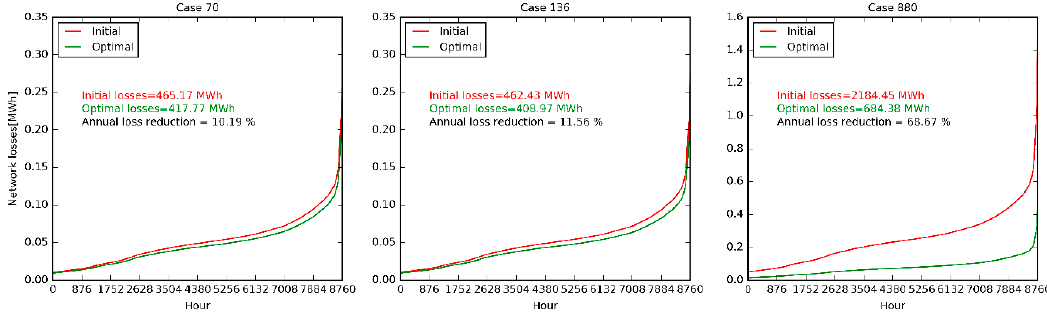
Figure 9. Network voltage profile for initial and optimal network topology.